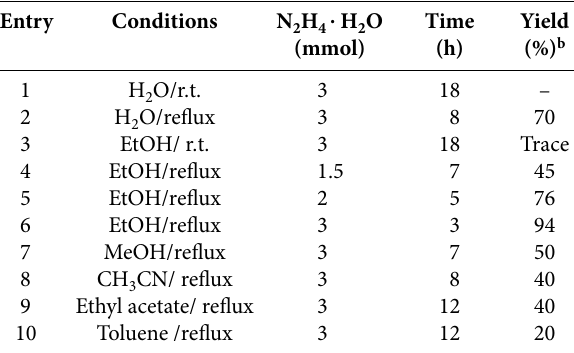
Table 2. Optimization study of the hydrazine hidrate and different solvents on the reduction of 4-chloronitrobenzene. a